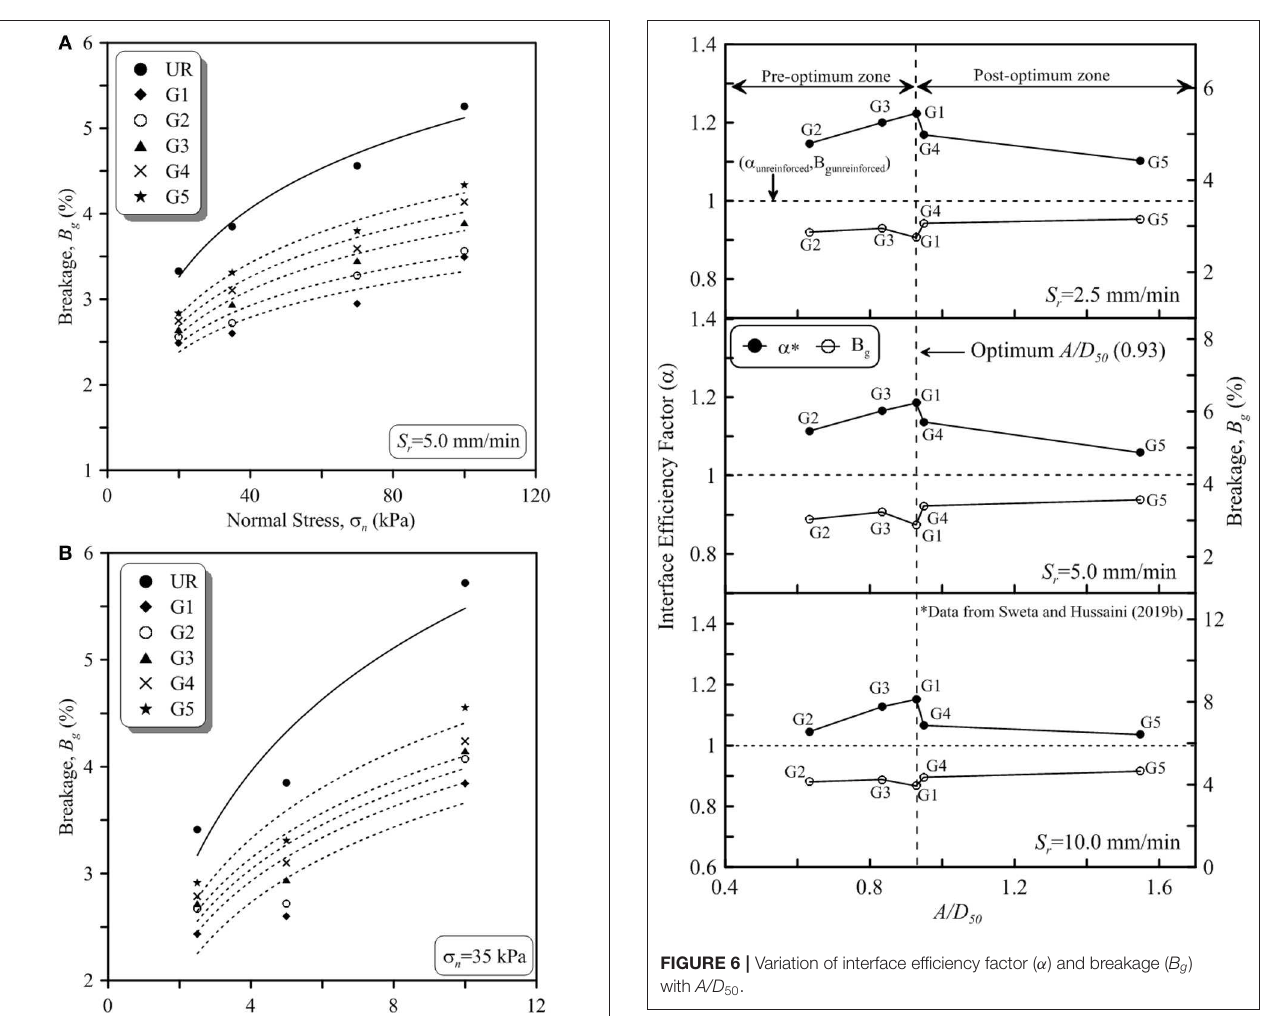
≤ 0.93 while the post-optimum zone lies in the range of 0.93 ≤ A/D 50 ≤ 1.54. The R 2 values for the models presented here vary from 0.88 to